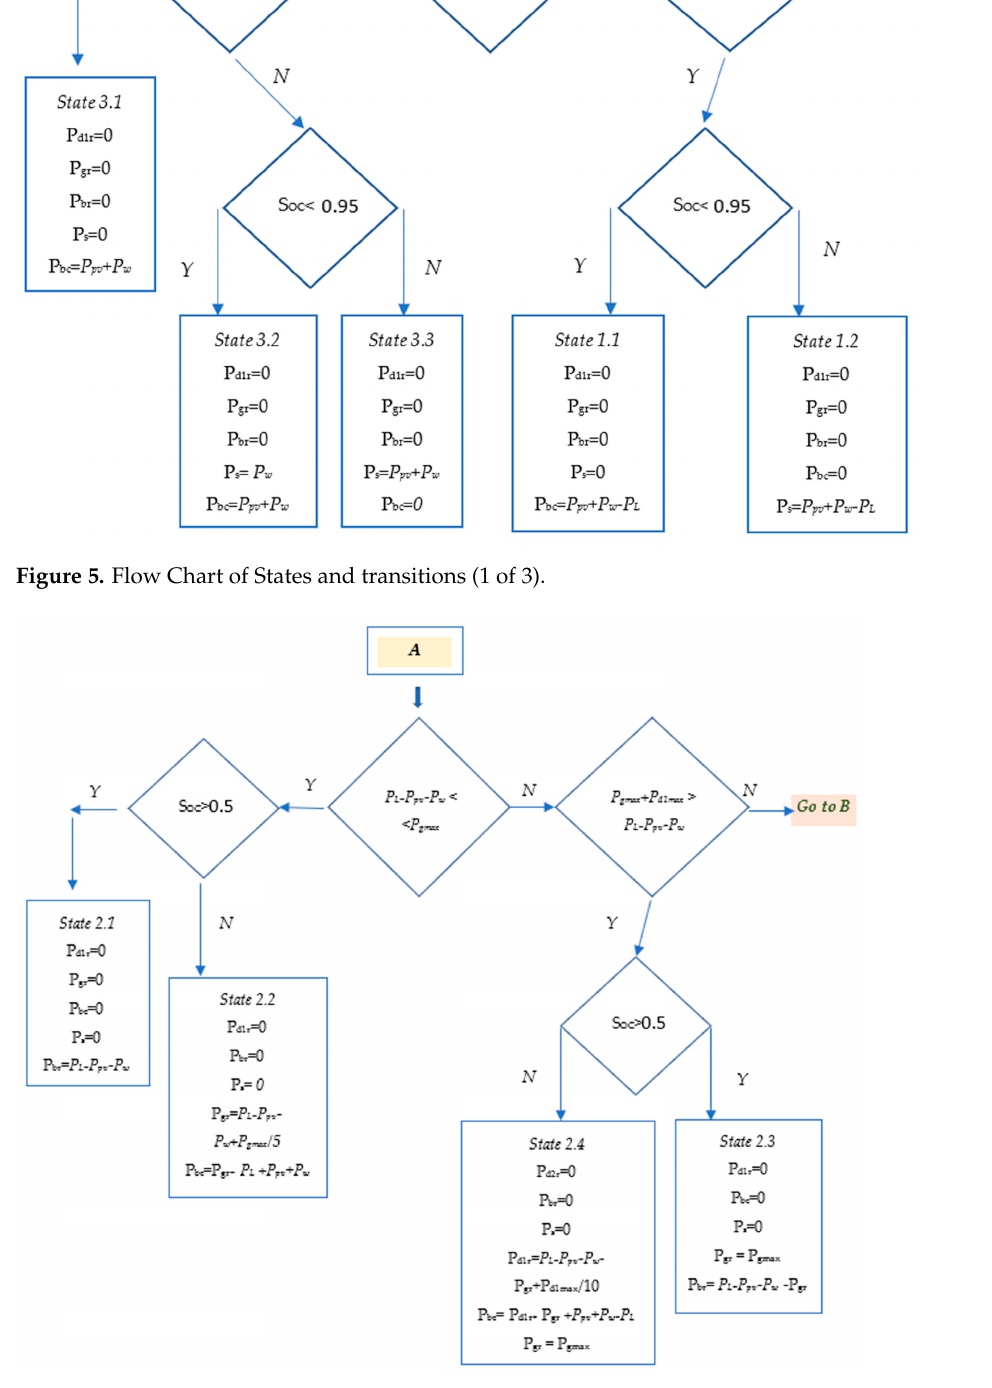
Figure 6. Flow Chart of States and transitions (2 of 3).